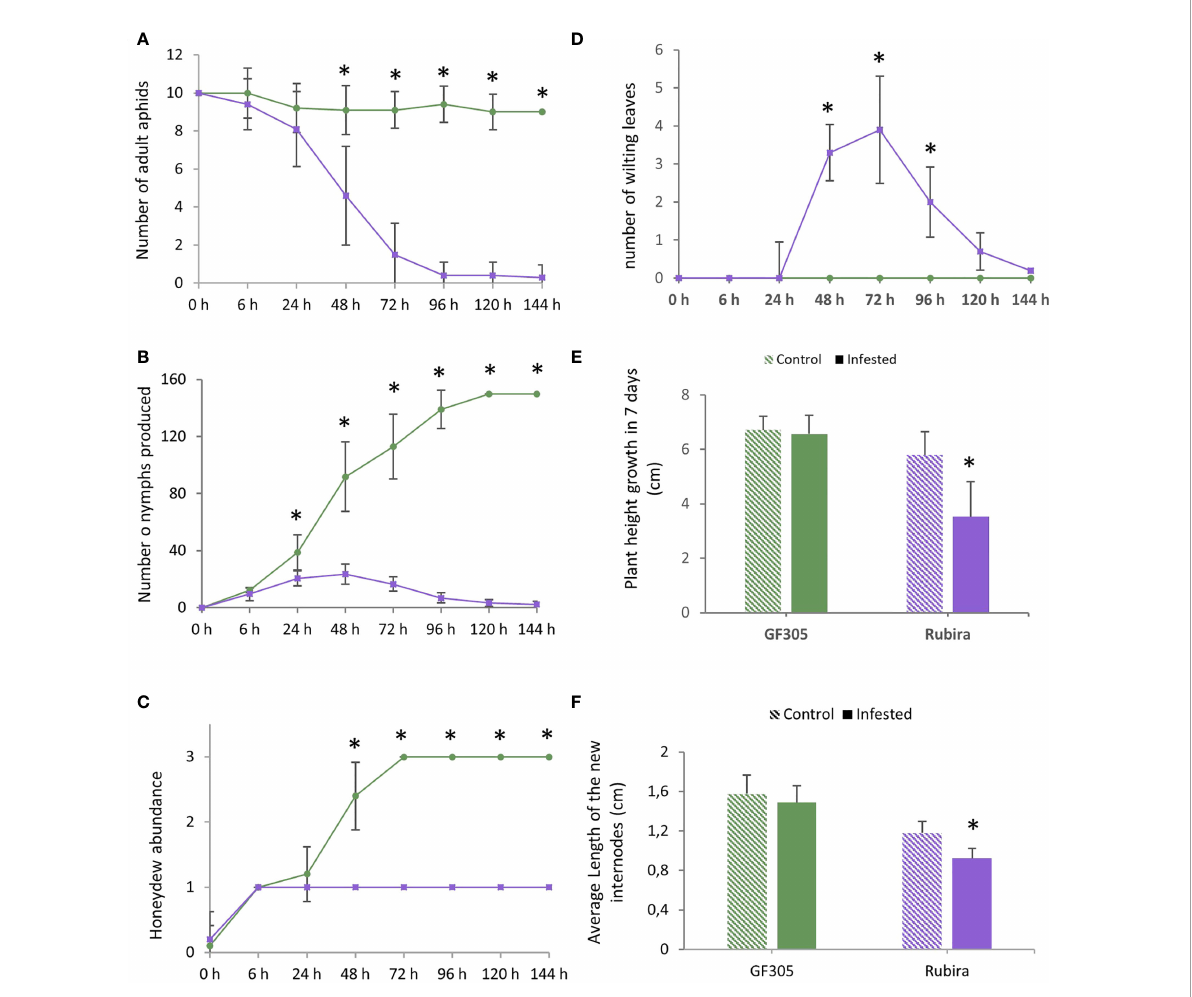
FIGURE 1 Aphid behavior and plant symptoms after infestation by GPA. Signi fi cant differences according to a Mann Whitney test are indicated (p.value<0.01 *). (A) Number of remaining aphids (out of ten adult deposited) on the susceptible GF305 (green circles) and the resistant Rubira (purple squares) seedlings over 6 days. (B) Number of nymphs produced. (C) Honeydew abundance expressed per classes (0: absence; 1: low; 2: medium; 3: high). (D) Number of wilting leaves on the growing shoot. (E) Height growth of the plants in seven days. (F) Average length of new internodes formed in 7 days